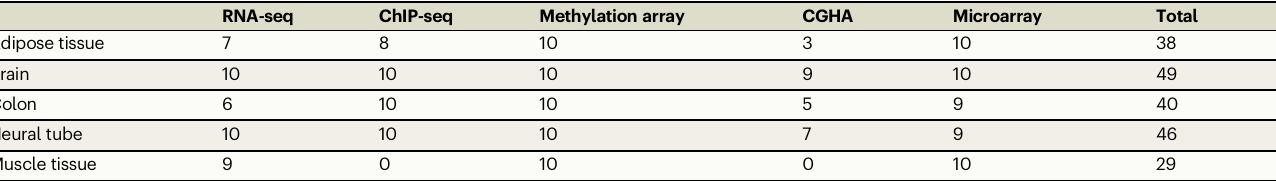
Eachrowcorrespondstooneof fi vetop-performingNLP-MLtissuemodels.Thelastcolumnshowsthetotaloutof50thateachofthesemodelsannotatedcorrectly.Columns2 – 6showthenumberof samples(out of10) from eachexperimenttype that each tissue model